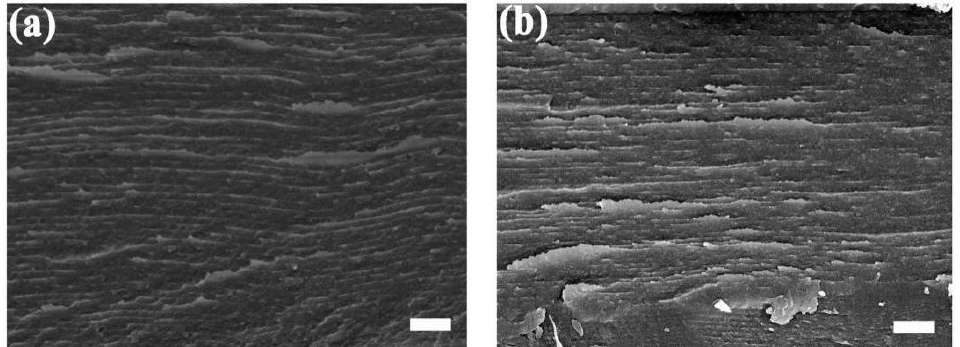
Figure 5. SEM images of fractured surface of ( a ) CLC film and ( b ) CLC-PAA photonic crystal hydrogel film when the films were cut perpendicularly to the surface of films. scale bar: 1 μm.